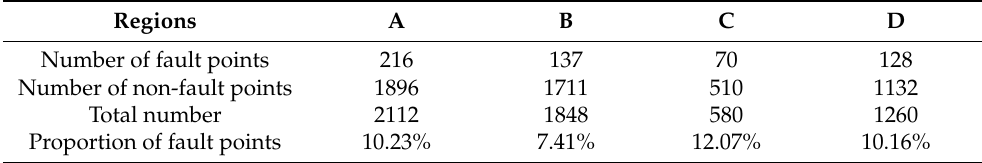
Table 2. Statistical table of faults in each region. Regions